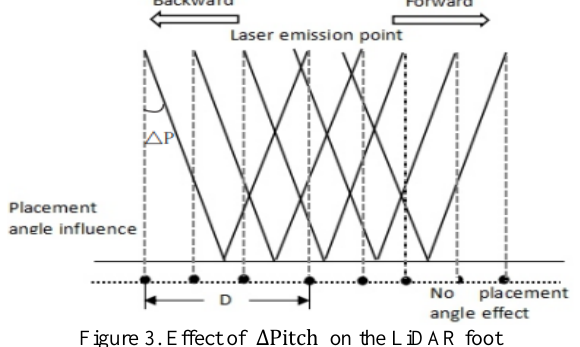
Figure 3. Effect of on the LiDAR foot (Zhang, 2007) Δ Pitch 2.3 Influence on the LiDAR Foot 𝚫𝐘𝐚𝐰